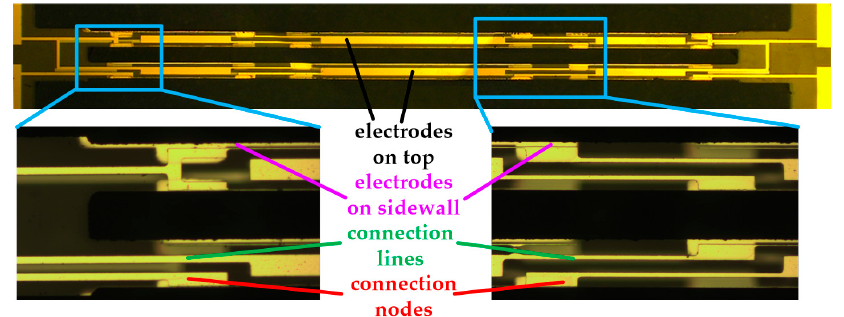
Figure 12. Manufactured quartz DETF and the partial enlarged view.